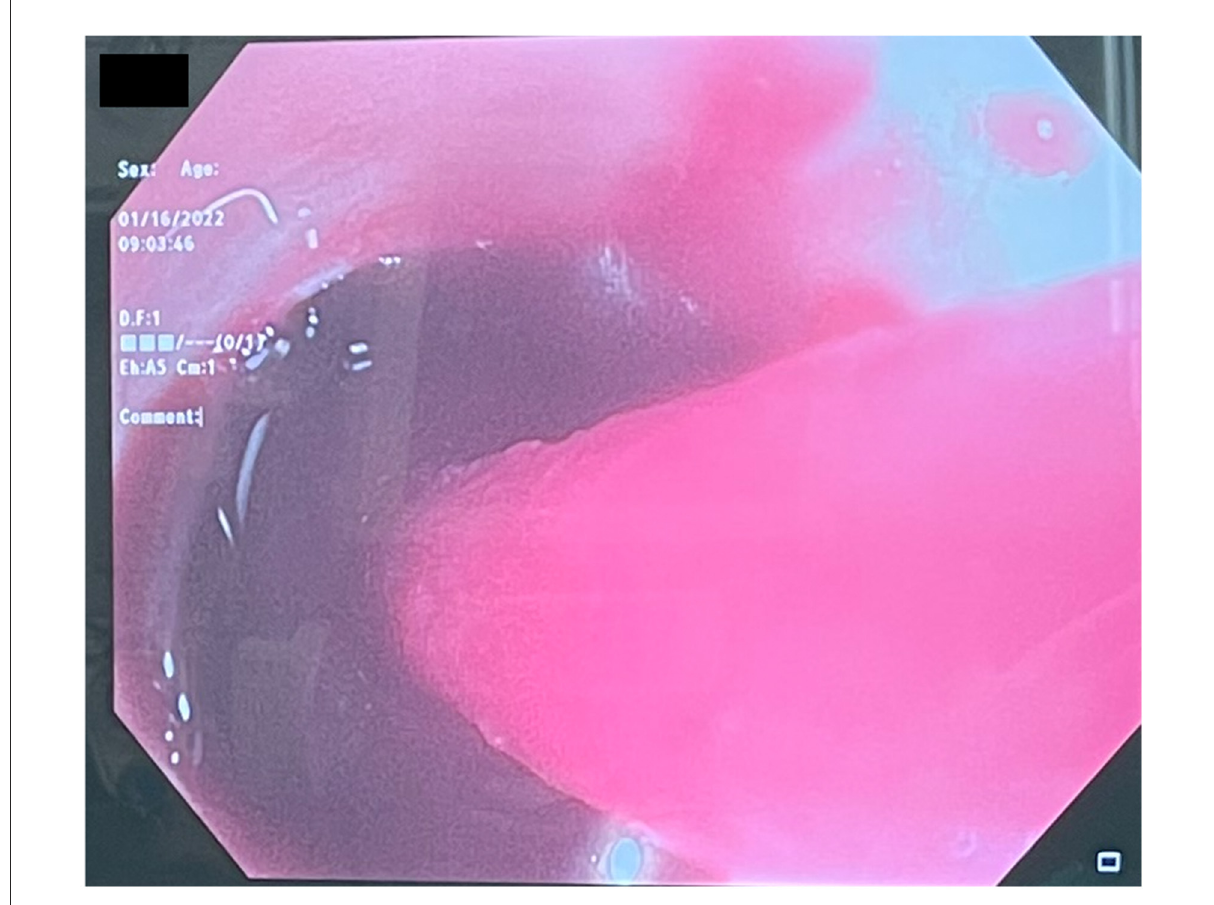
FIGURE2 Bronchoscopy reveals massive